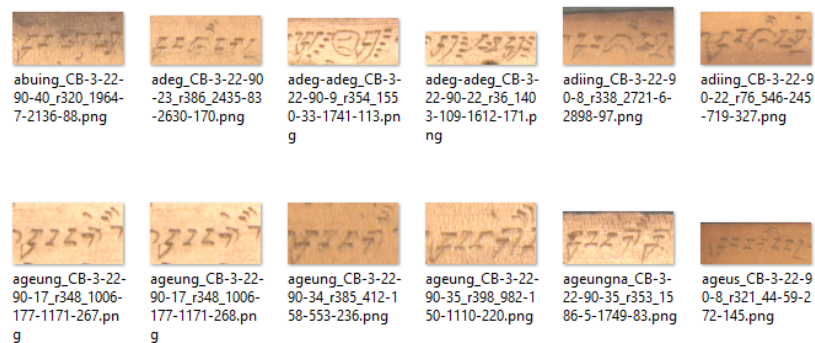
Figure 19. Sundanese word dataset.